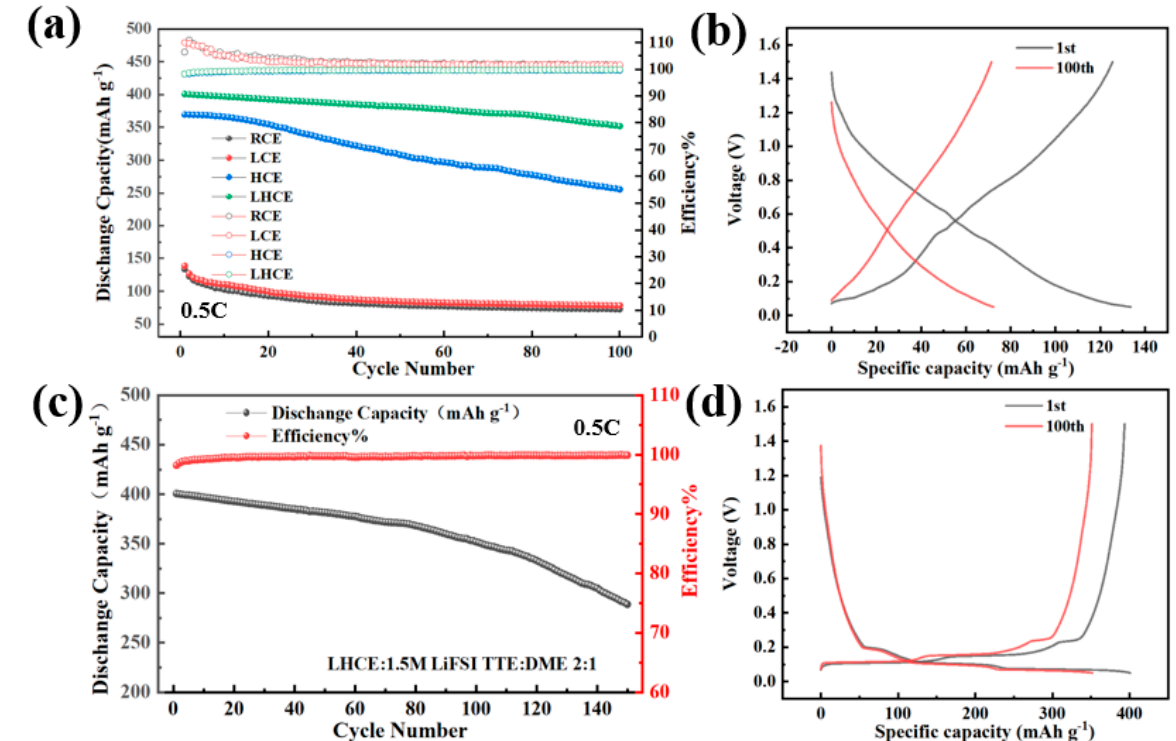
Figure 5. Capacity-voltage curves for Li||C batteries ( a ) 100 long cycles in four electrolytes, ( b ) 1st and 100th cycles in RCE, ( c ) 150 long cycles in LHCE, ( d ) 1st and 100th cycles in LHCE.